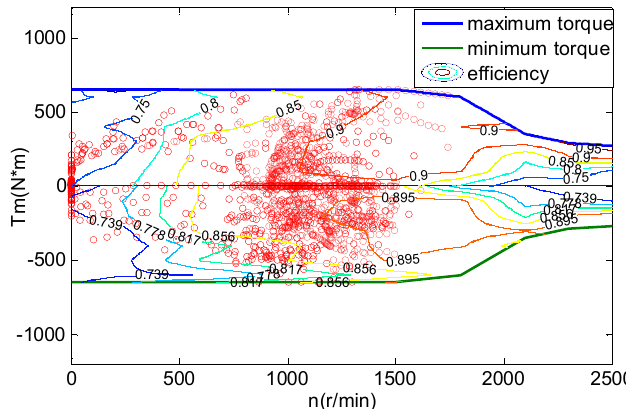
Figure 20. Distribution of the engine operating point (ECMS).